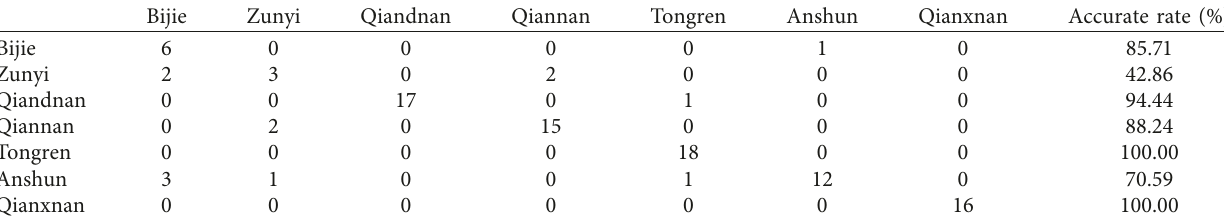
Table 5: Nineteen classification results by PLS-DA for seven different origins.